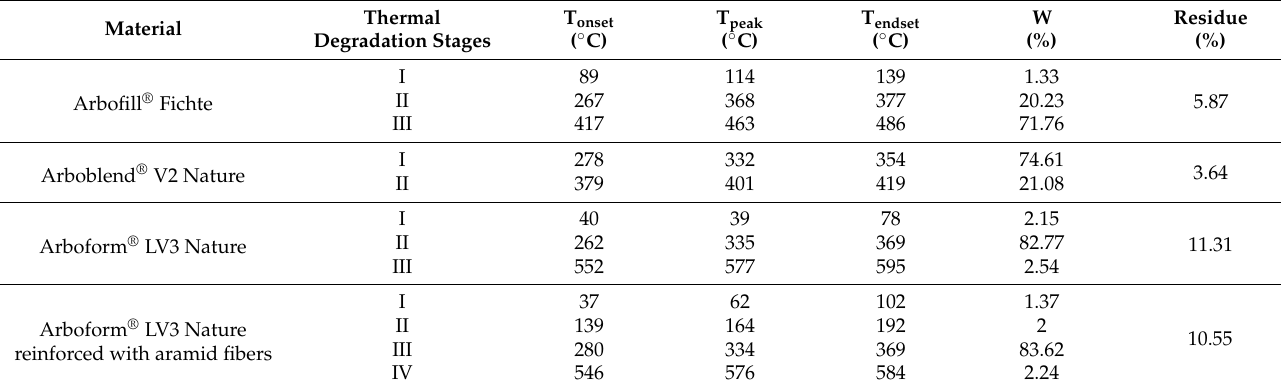
Table 3. Thermogravimetric characteristics of the studied